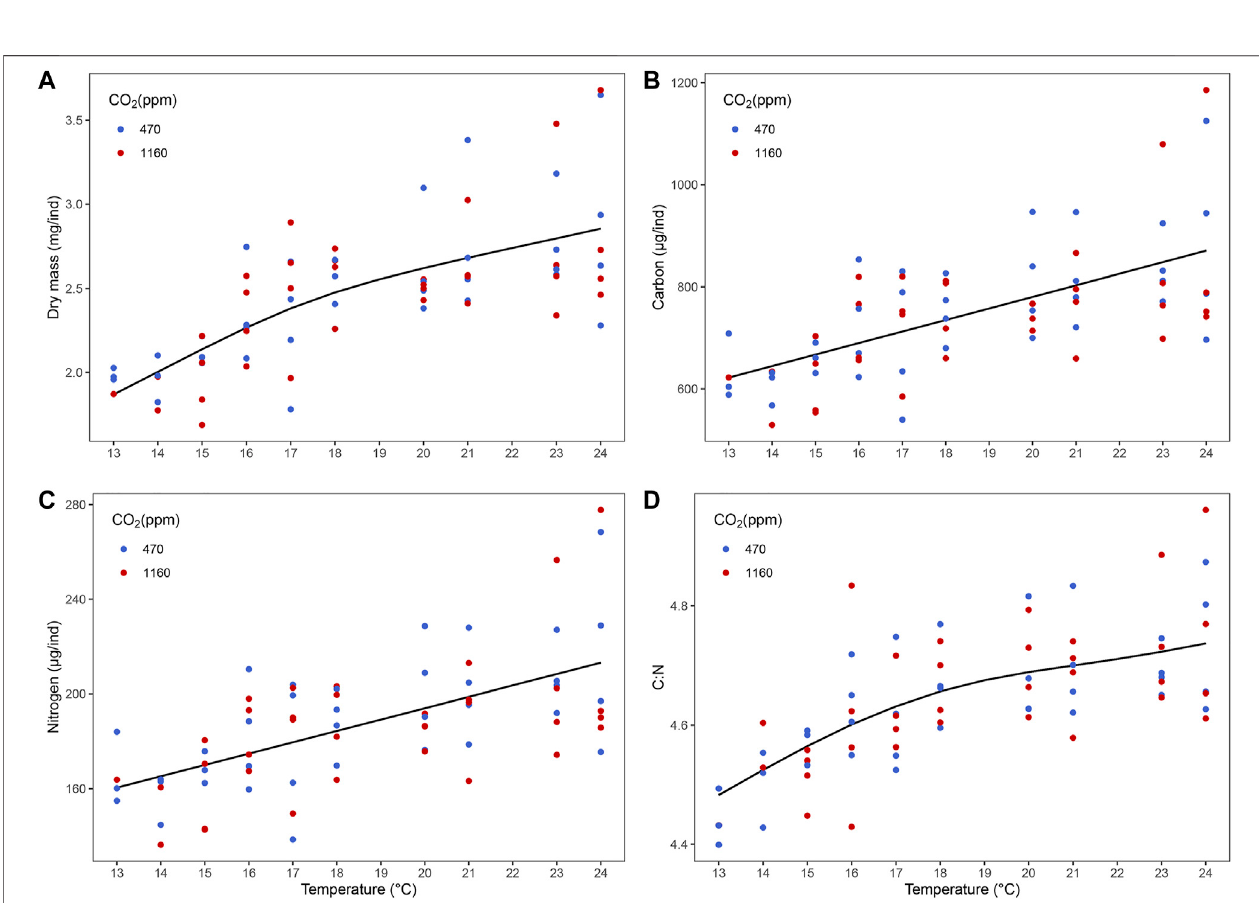
FIGURE 2 | Effect of temperature on biomass of stage III Homarus gammarus larvae. (A) dry mass, (B) carbon content, (C) nitrogen content and (D) C:N was positivelycorrelatedwithtemperature.Eachpoint represents theaverageresponse quanti fi edinlarvaeoriginatedfromthesame female.Curves correspond tosmooths fi tted with the best (general additive) model, obtained after backwards model selection.